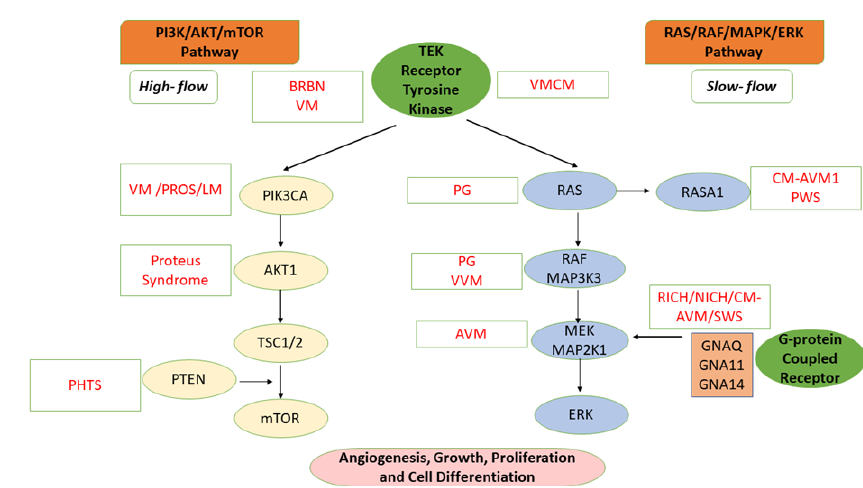
Figure 1. Molecular Mechanism of Vascular Anomalies: PI3K/AKT/mTOR and RAS/MAPK/ERK Signaling Pathways [1,4,5]. VM: Venous malformation; LM: Lymphatic malformation; AVM: Arte- riovenous malformation; BRBN: Blue rubber bleb nevus (BRBN) syndrome; PHTS: PTEN hamar- toma tumor syndrome; CM-AVM: Capillary malformation—Arteriovenous malformation syndrome; PROS: PIK3CA-related overgrowth spectrum; RICH: Rapidly involuting congenital hemangioma; NICH: Noninvoluting congenital hemangioma; VMCM: Cutaneomucosal venous malformation; PWS: Parkes Weber syndrome; VVM: Verrucous venous malformation; PG: Pyogenic granuloma; SWS: Sturge-Weber syndrome; MAP2K1 : Mitogen-activated protein kinase kinase 1; ERK: Extracellular signal-regulated kinase; mTOR: Mammalian target of Rapamycin; PTEN: Phosphatase and tensin homolog; GNAQ: Guanine Nucleotide-Binding Protein G(Q) Subunit Alpha; TSC1/2: Tuberous sclerosis complex 1/2; TEK: TEK tyrosine kinase; RAF: Rapidly accelerated fibrosarcoma; PIK3CA: Phosphatidylinositol 4,5-Bisphosphate 3-Kinase Catalytic Subunit Alpha; RASA1: RAS p21 protein activator